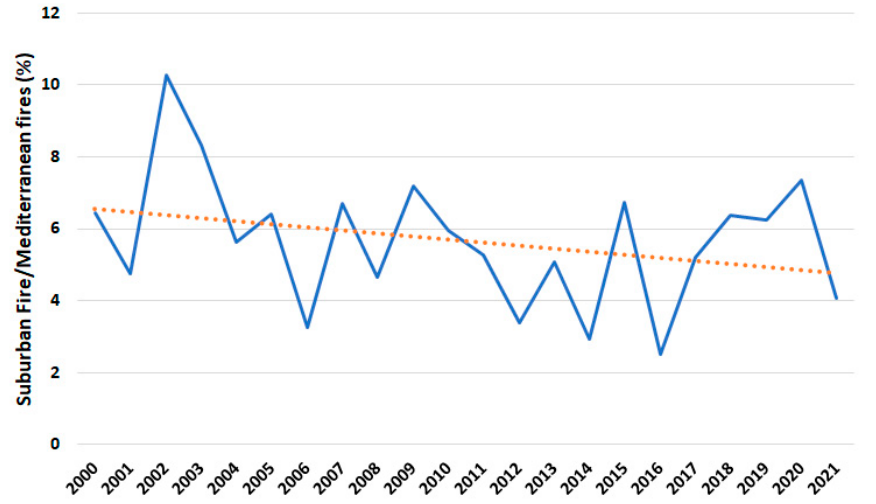
Figure 5. The ratio (%) of the number of articles published related to suburban fires to the number of articles published related to Mediterranean fires. Red line represents the trendline. Data retrieved from Web of Science [32] for dates between 2000 and 2021.